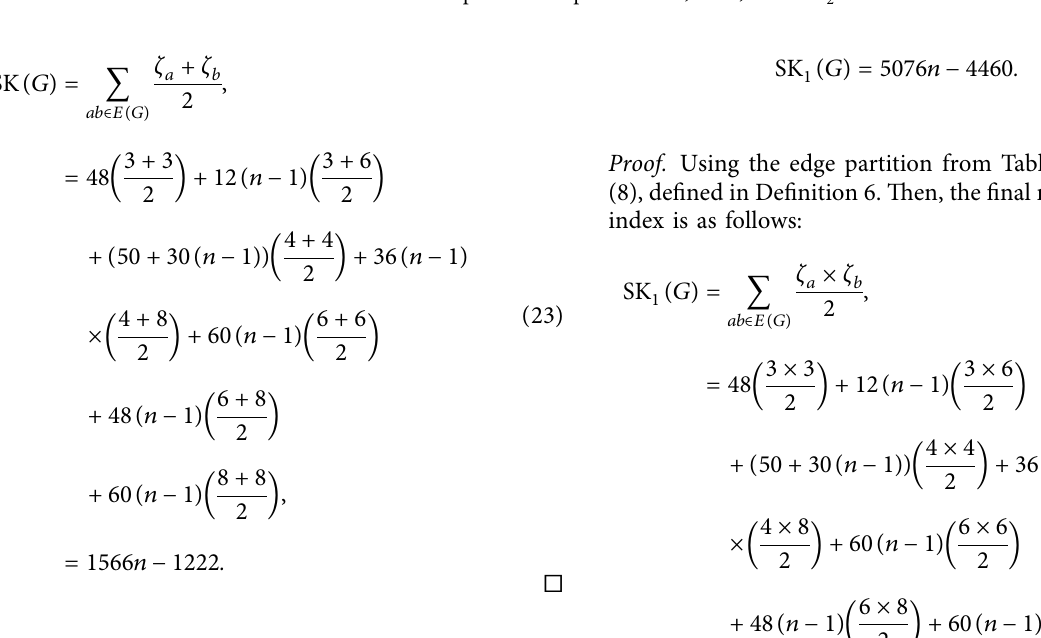
Figure 4: Graphical examples for SDI, RRR, and RM